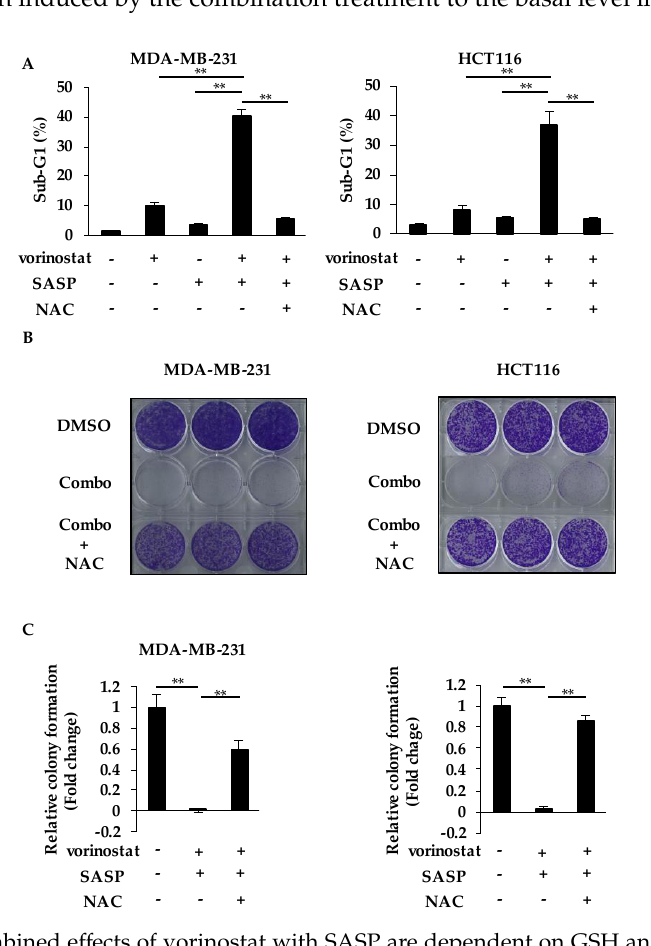
Figure 5. The combined effects of vorinostat with SASP are dependent on GSH and ROS. ( A ) Flow cytometry analysis of cell death induced by cotreatment of vorinostat with salazosulfapyridine (SASP) in the presence or absence of N-acetylcysteine (NAC). MDA-MB-231 and HCT116 cells were treated with 1.6 µ M vorinostat, 500 µ M SASP, or a combination of both with / without 5 mM NAC for 144 h. The percentages of cells in the sub-G1 population were analyzed by flow cytometry. Columns, means ( n = 3); bars, SD. ** p < 0.01. ( B , C ) Colony formation of cells cotreated with vorinostat and SASP in the presence or absence of NAC. MDA-MB-231 and HCT116 cells were treated with a combination of 1.6 µ M vorinostat and 500 µ M SASP with / without 5 mM NAC for 144 h, and then the media were replaced. After the cells were cultured for 3–7 more days, the colonies were stained with crystal violet. Representative images of colony formation ( n = 3) are shown ( B ). Colony formation was quantified using ImageJ ( C ). The data obtained with DMSO control were taken as 1. Columns, means ( n = 3); bars, SD. ** p <